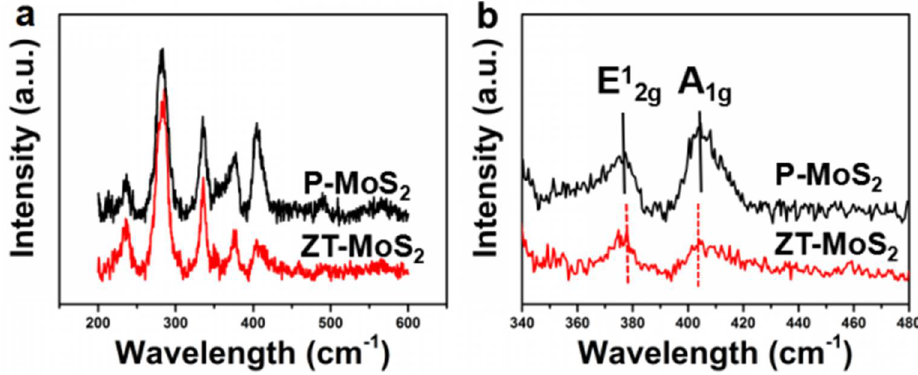
Figure 2. ( a ) Raman spectra of the P-MoS 2 and ZT-MoS 2 after HCl etching, ( b ) the corresponding high resolution of E 12g and A 1g in ( a ).